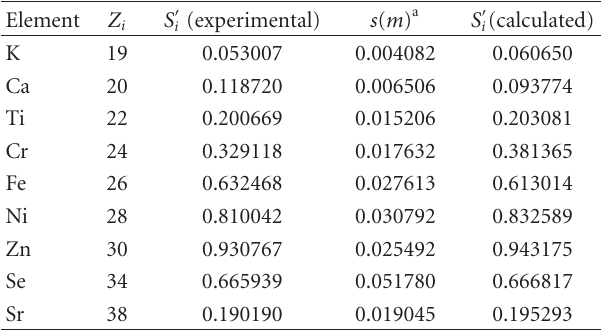
Table 2: Experimental and calculated mean relative sensitivity, S (cid:3) i , and mean standard deviation for chemical elements emitting X-K rays for 19 ≤ Z i ≤ 38.